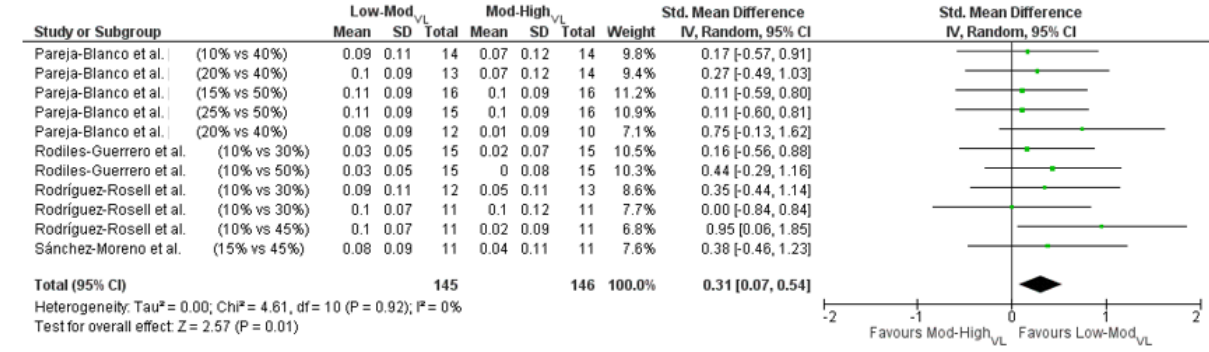
Table 3. Characteristics of the sample and the resistance training (RT) programs conducted by Low- Mod VL and Mod-High VL thresholds.